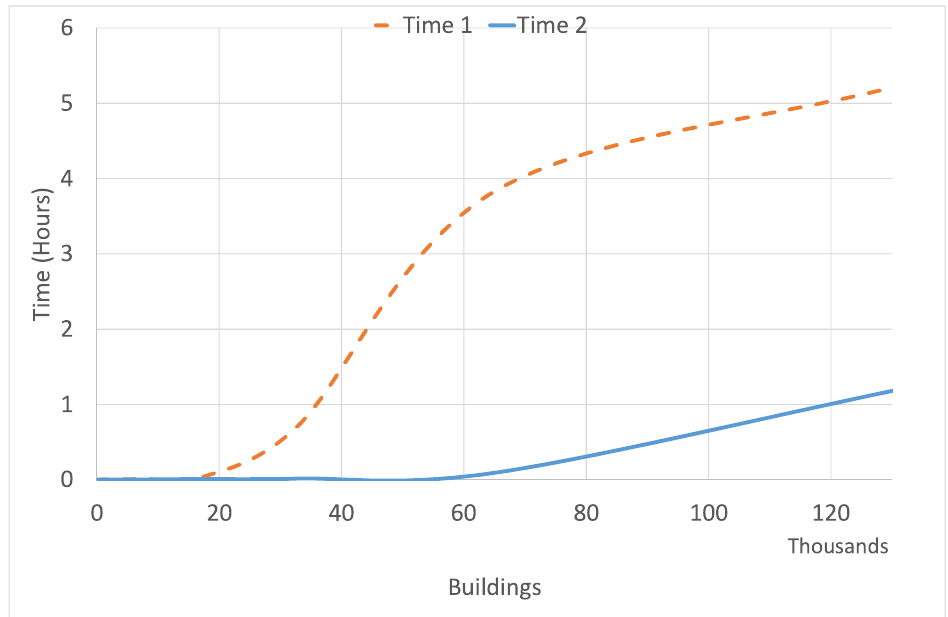
Figure 9. A runtime comparison between the two different hardware